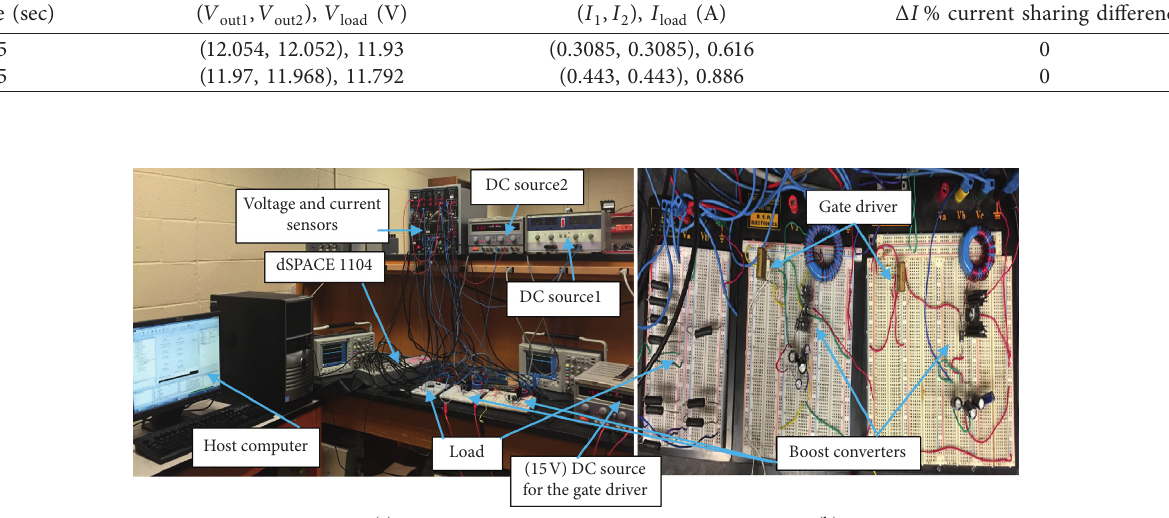
Figure 12: Photographs of the experimental setups. (a) Laboratory prototype. (b) Boost converters and load.